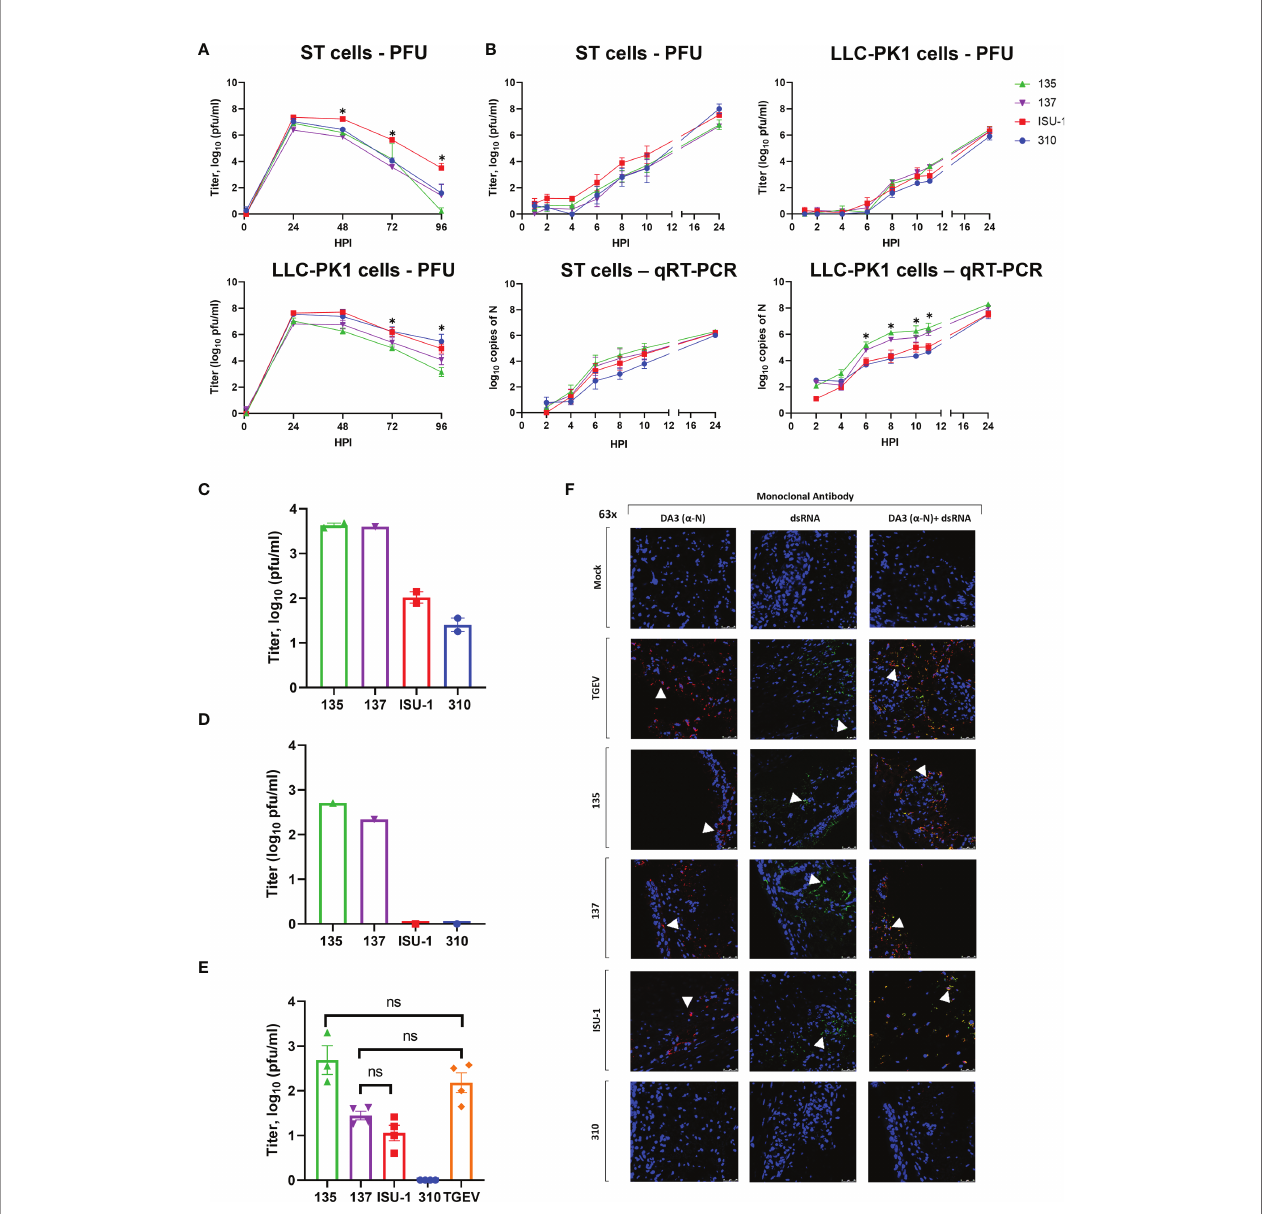
FIGURE 1 | Replication of PRCV strains in cell lines and in ex vivo tracheal organ cultures. ST and LLC-PK1 cells were inoculated with 10 4 PFU (MOI ~ 0.01) of PRCV strains 135, 137, ISU-1 or 310. The quantity of infectious progeny in cell supernatants were determined at 24 h (A) or 2 h (B) intervals by titration in ST cells. In addition, viral RNA was quanti fi ed from cell lysates harvested at the same time points by qRT-PCR using a primers and probes targeting the N gene. In (A) and (B) each time point represents the mean of three independent experiments with error bars showing the standard error of the mean (SEM). Two-way ANOVA with a Tukey test was used * (p<0.05). For ST cells the star indicates that the ISU-1 titres were higher than those for 137 at 48 - 72 hpi, those for 135 at 48 and 96 hpi, and for 310 at 72 hpi. For LLC-PK1 cells the star indicates that the ISU-1 titres are greater than those for 135 at 72 and 96 hpi. However, (B) the quantity of N RNA detected for both 135 and 137 was higher than the RNA detected for to ISU-1 and 310. Tracheal organ cultures (TOCs) were prepared with trachea harvested from 4-week-old piglet in three experiments from separate animals (C – E) . TOCs in (C, D) were inoculated with 10 4 PFU of 135, 137, ISU-1 or 310 and the quantity of infectious progeny virus in the supernatants at 24 hpi were determined by titration in ST cells (C, D) . (C) represents the use of two TOCs and (D) a single TOC. (E) TOCs were inoculated with 10 5 PFU of either PRCV 135, 137, 310, ISU-1, TGEV or mock infected with medium only and progeny infectious virus in the supernatants at 24 hpi were determined by titration in ST cells. No virus was detected in the mock control. Statistical differences were evaluated using a one-way ANOVA with a Tukey test for multiple comparisons. No statistical differences (ns) in the amounts of progeny virus produced were identi fi ed between ISU-1 & 137, 135 & TGEV or 137 & TGEV; all other comparisons were signi fi cant (p<0.05). (F) TOCs from (E) at 24 hpi were fi xed in 4% formalin for 72 h before freezing in OCT. 100 m m cryosections were labelled using anti-N (DA3; Red) and/or anti-dsRNA (Green). Nuclei were stained with DAPI (blue). White arrow indicates the location of detected virus. Images were obtained by a confocal microscope with high powered images (63x magni fi cation) for DA3 only, anti-dsRNA only and co-localization of both DA3 and anti-dsRNA. Scale bars indicate 25 m